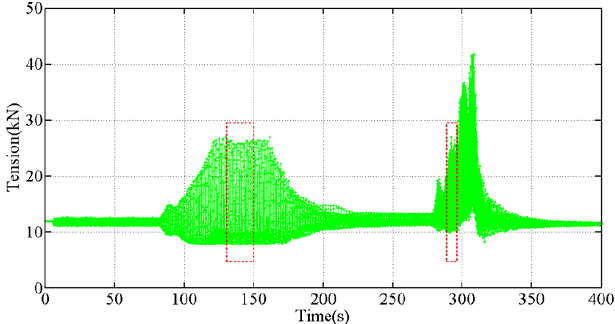
Figure 14. The dynamic tension results in the second galloping experiment, in which different drive frequencies were used.